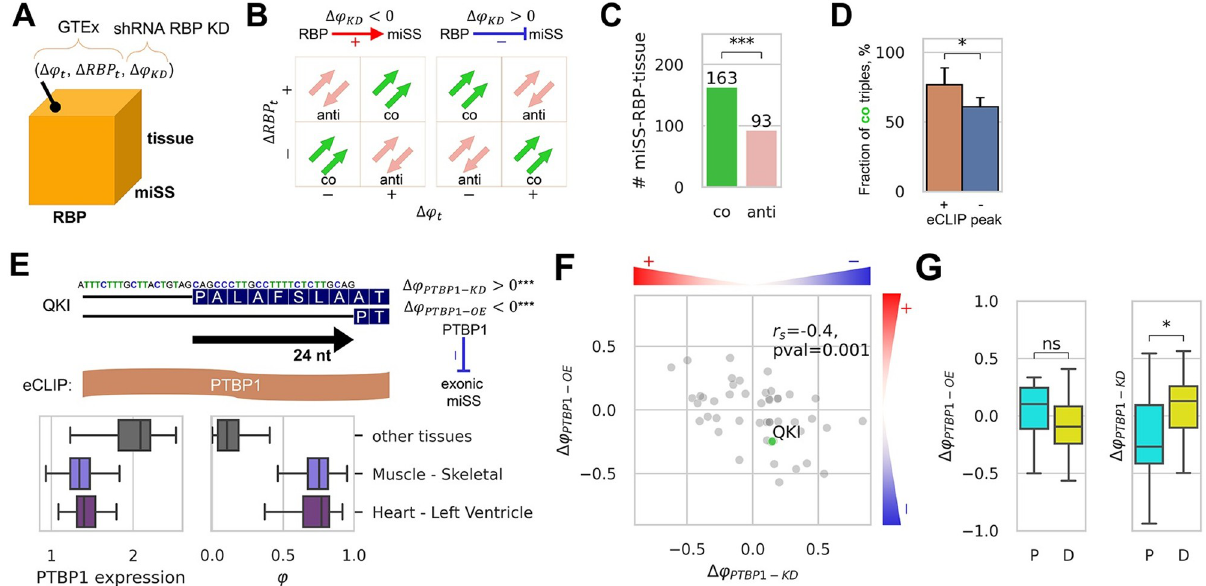
Fig 3. Regulation of miSS by RBP. (A) Each miSS-RBP-tissue triple is characterized by three metrics: ( Δ φ , the change of miSS relative usage in tissue t ; t Δ RBP t , the change of the RBP expression in tissue t ; and Δ φ KD , the change of miSS relative usage upon inactivation of RBP by shRNA-KD. (B) The response of miSS to RBP inactivation defines activating ( Δ φ KD < 0, red) and repressing ( Δ φ KD > 0, blue) regulation, which together with other metrics define co-directed and anti-directed triples. (C) The number of co-directed triples is significantly greater than the number of anti-directed triples. (D) The fraction of co-directed miSS-RBP-tissue triples (# co /(# co + # anti )) is significantly greater among triples supported by an eCLIP peak of the RBP near miSS as compared to non-supported triples. (E) A deletion of eight aminoacids in the QKI gene caused by the exonic miSS overlapping with PTBP1 eCLIP peak (top). In muscles and heart, the expression of PTBP1 (log 2 TPM ) is suppressed, while the relative usage of the miSS is promoted (bottom). The miSS is activated in response to PTBP1 inactivation and is inhibited in response to PTBP1 overexpression, suggesting downregulation by PTBP1 . (F) The responses of miSS to PTBP1 overexpression and inactivation by shRNA-KD are negatively correlated. Shown are 50 miSS, in which the response to PTBP1 overexpression or the response to shRNA-KD of PTBP1 is statistically significant (Q-value < 5%) and substantial (| Δ φ | > 0.05). (G) The responses of proximal (|shift| < 5 nt) and distal (|shift| � 5 nt) miSS to PTBP1 overexpression and inactivation by shRNA-KD are opposite a different mode of regulation for polypyrimidine tracts overlapping the TASS region.